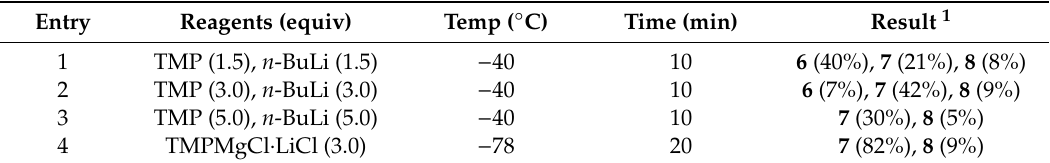
Table 1. Vinyl anion aldol reaction of aldehyde 6 .